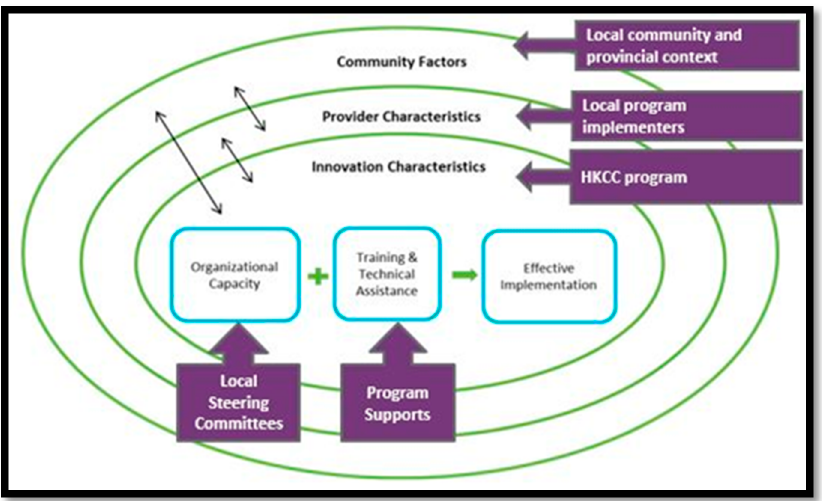
Figure 1. Adapted from Durlak & DuPre’s Ecological Framework for Understanding Effective Implementation (2008) [22].